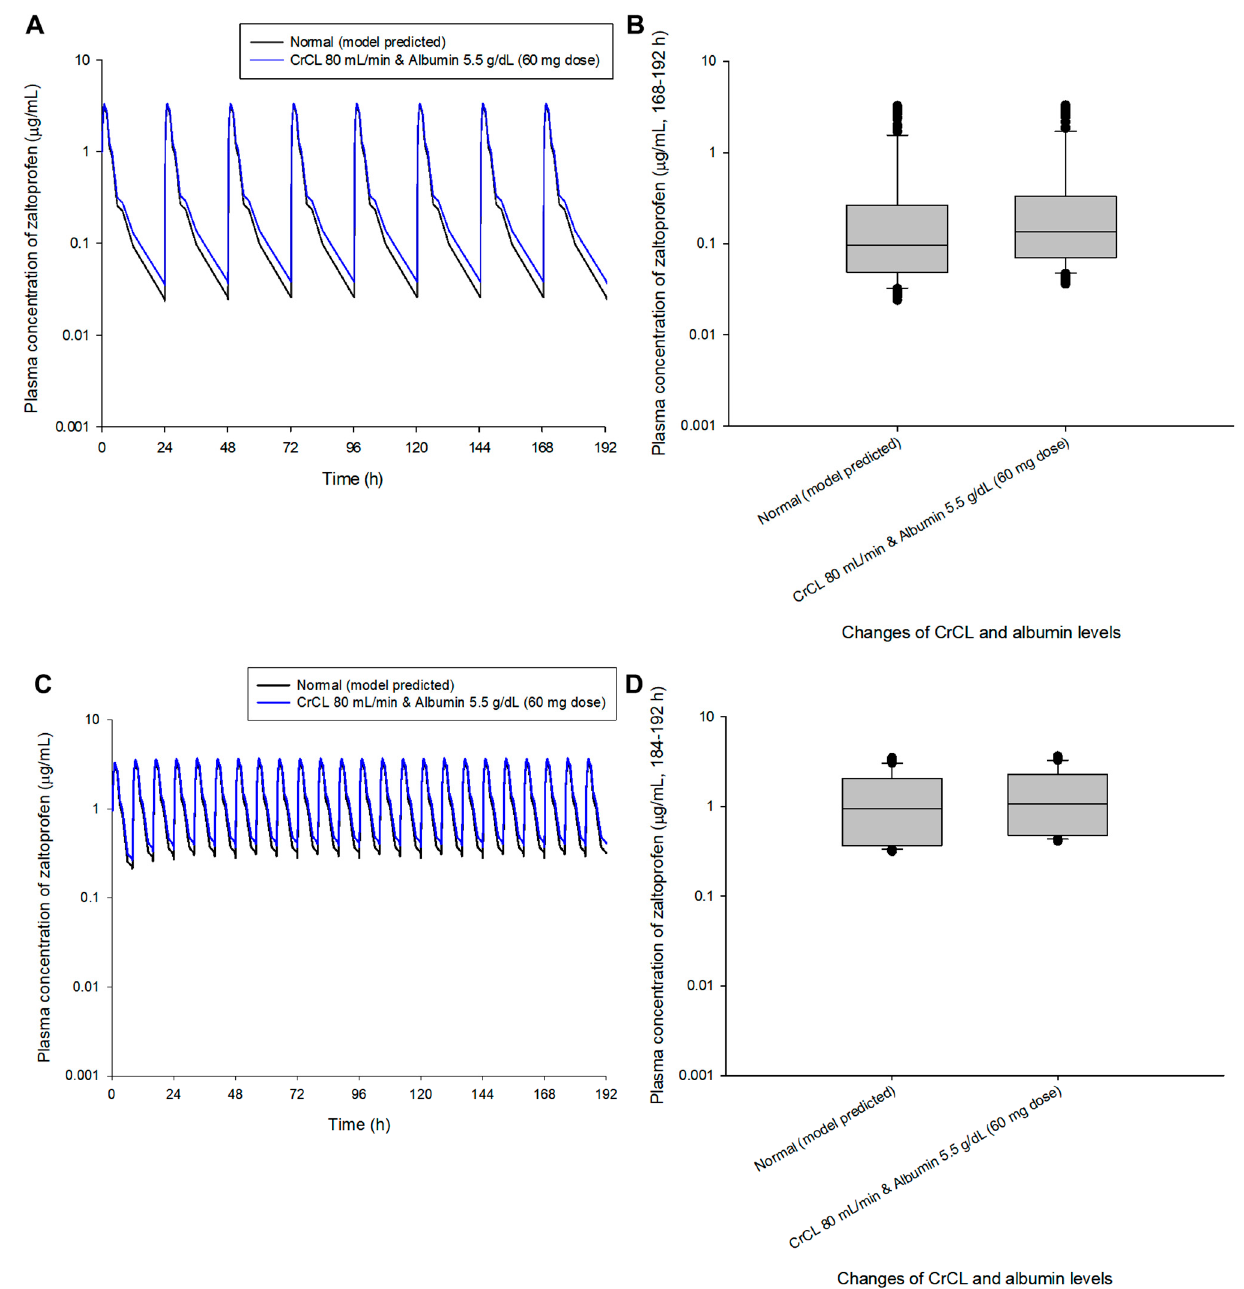
Figure 4. Simulation of the pharmacokinetic prediction profile after multiple (24 h ( A , B ) and 8 h intervals ( C , D )) oral administrations of zaltoprofen predicted by arbitrarily adjusting the dose to 60 mg for the group with CrCL and albumin levels of 80 mL/min and 5.5 g/dL, respectively. The lines in the graph ( A , C ) indicate the mean values corresponding to 50% of each group. Normal in the graph indicates the 50% average predicted by the model established in this study (based on the group with median values of CrCL and albumin of 104.38 mL/min and 4.90 g/dL, respectively). Comparison ( B , D ) of predicted intergroup plasma concentrations at steady-state (168–192 h ( B ) and 184–192 h ( C )) following a dose change of zaltoprofen to 60 mg for a group with CrCL and albumin levels of 80 mL/min and 5.5 g/dL, respectively.